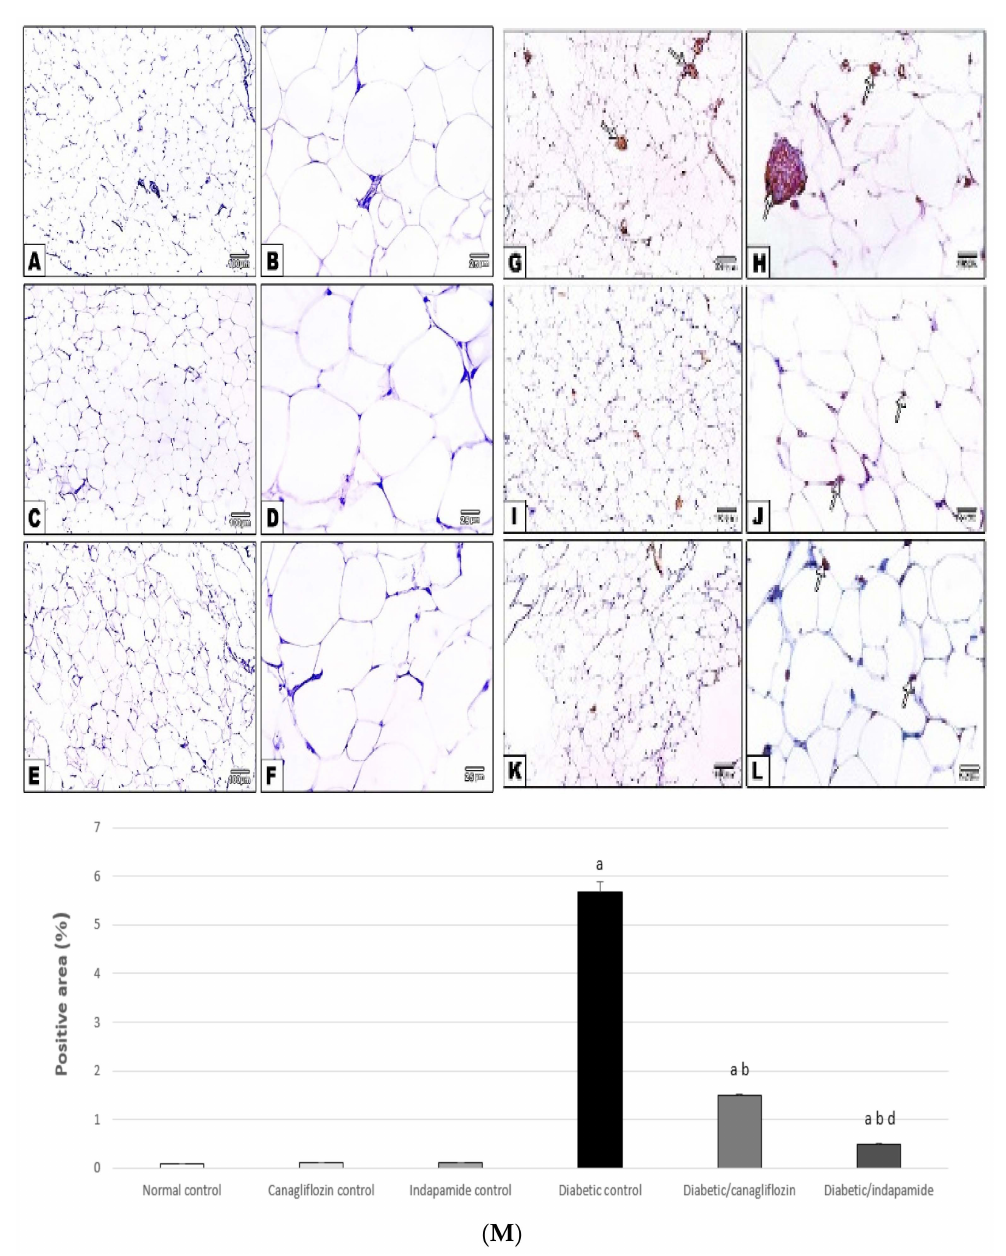
Figure 15. Immuno-stained adipose specimen against CD68 revealing negative immuno-staining in the normal ( A , B ), CANA ( C , D ), INDA ( E , F ) CTRLs. Increased positive immuno-staining of CD68-labeled macrophages (arrows) in the diabetic CTRL ( G , H ), and marked retraction in the CANA ( I , J ) and INDA ( K , L ) treatment groups. IHC counterstained with Mayer’s hematoxylin. Low magnification: 100 × bar 100; high magnification: 400 × bar 25. ( M ) Impact of daily